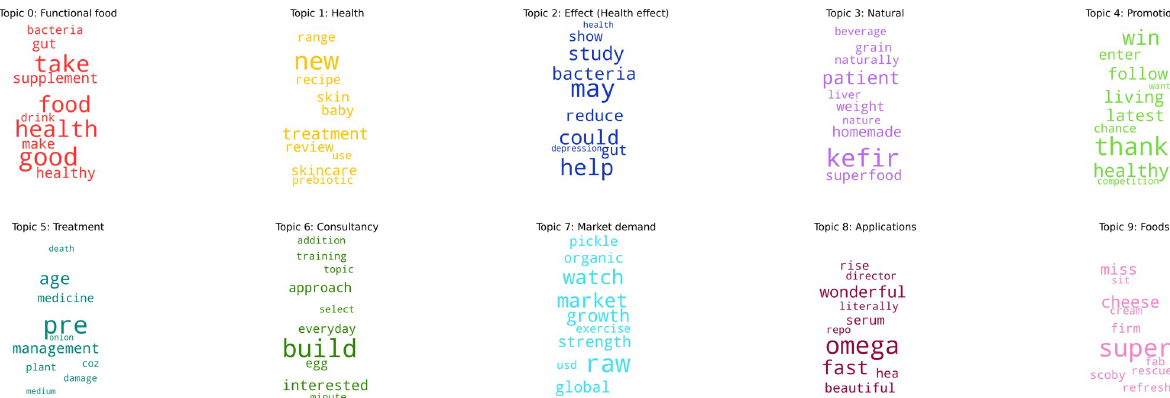
Fig 1. A series of word clouds depicting the top 10 words in each topic. The size of each word increases as a function of it’s relative frequency in the model. The model shows us the most prevalent words (and their weights) it has grouped together.